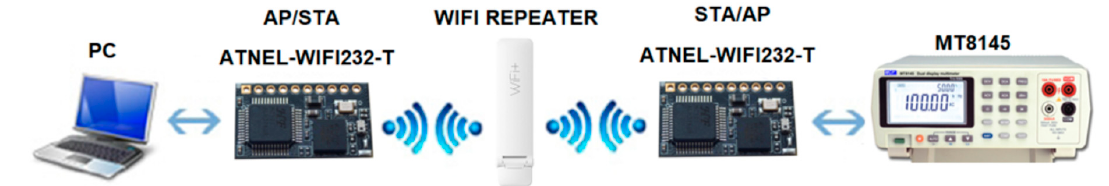
Figure 10. Modified WiFi communication link.